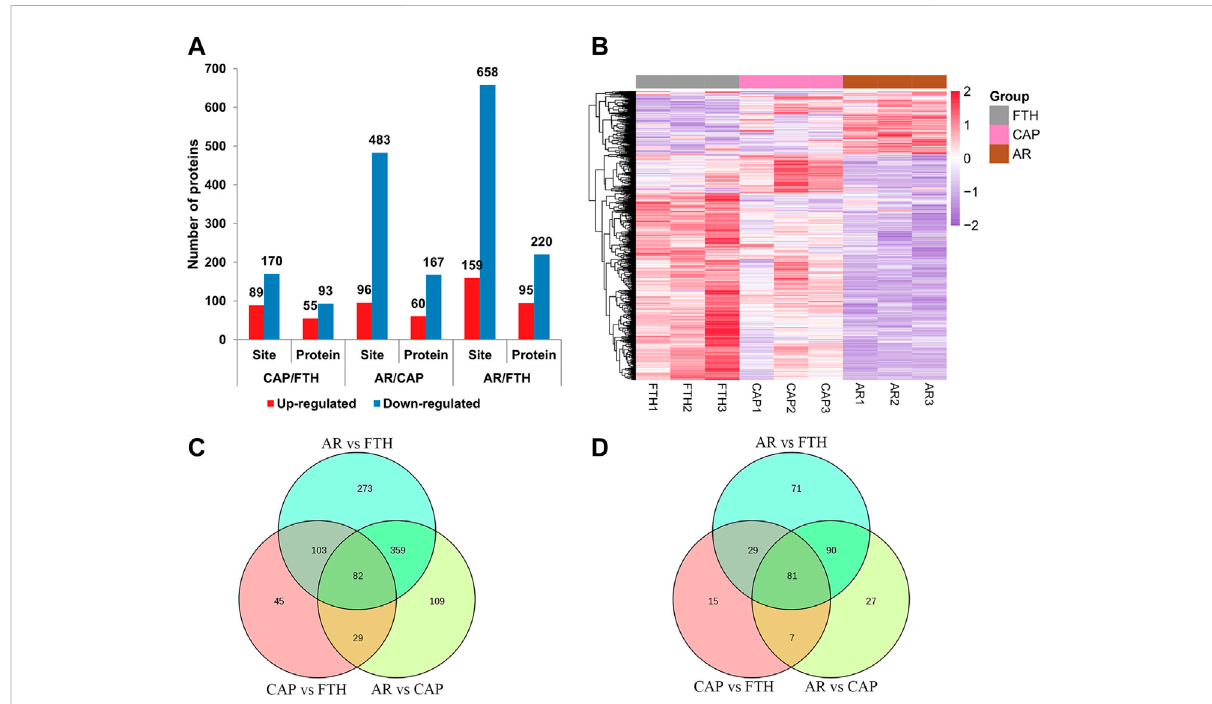
The Identi fi cation of differentially expressed proteins under three states of yak sperm (FTH, CAP, and AR). (A) The number of differentially expressed phosphorylation sites and their corresponding proteins. (B) The cluster analysis of the DEPPs in yak sperm. (C,D) The differentially expressed phosphorylation sites and their corresponding proteins in each group were displayed by Venn